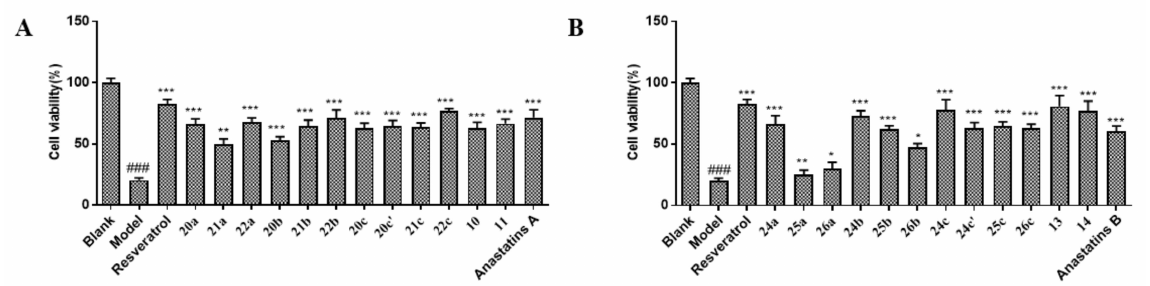
Figure 4. Anastatins A and B and their derivatives improved cell viability in H/R-stimulated H9c2 cells. ( A ) Anastatin A, its derivatives, and resveratrol at a final concentration of 10 µ M protected H9c2 cells against H/R-induced damage. ( B ) Anastatin B, its derivatives, and resveratrol at a final concentration of 10 µ M protected H9c2 cells against H/R-induced damage. ### p < 0.001 vs. blank. * p < 0.05, ** p < 0.01, *** p < 0.001 vs.